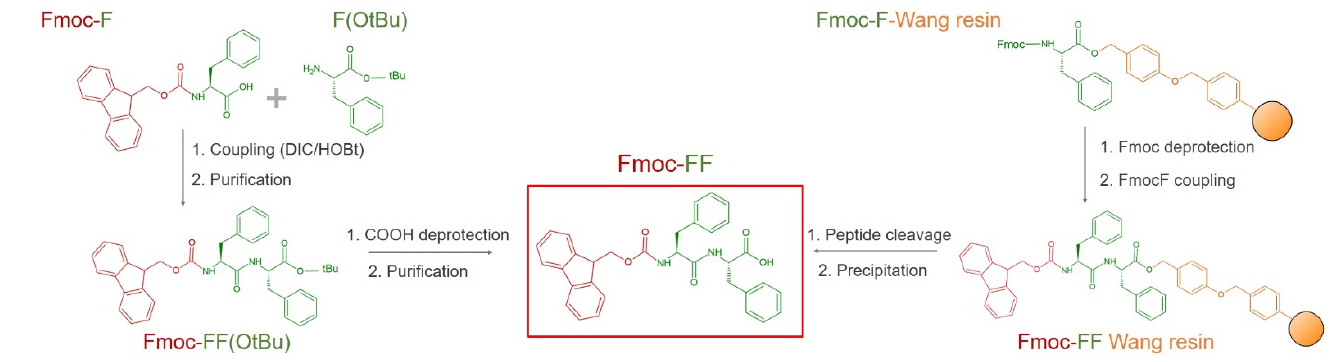
Figure 1. Scheme for the synthesis of Fmoc-FF (red rectangle) using liquid phase strategy (on the left) and solid phase peptide synthesis (SPPS) on the right. DIC : N , N ′-Diisopropylcarbodiimide; HOBt: 1-Hydroxybenzotriazole.